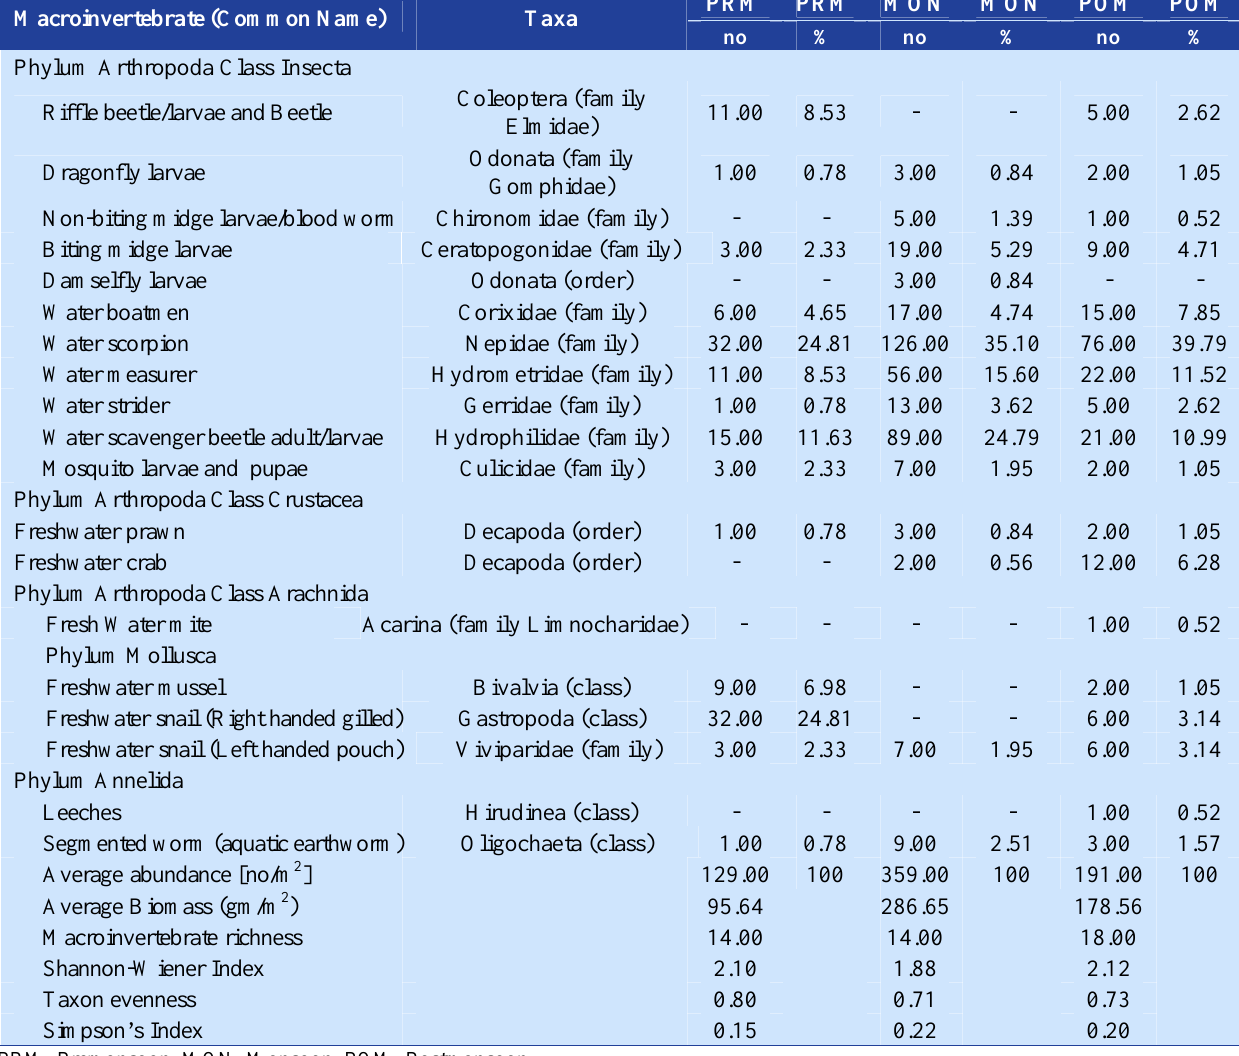
Table 1. Seasonal distributions and diversity indices of